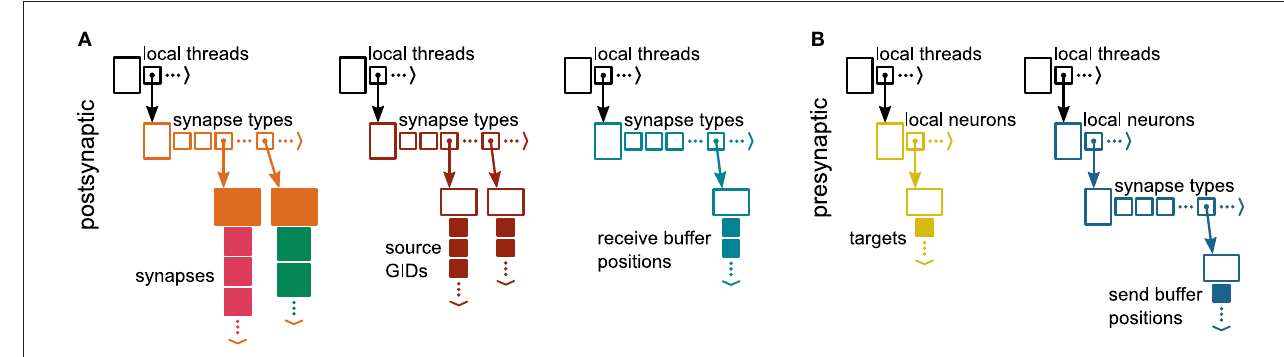
FIGURE 4 | Two-tier connection infrastructure for spiking and continuous-data connections on each MPI process. All components of the connection infrastructure hold data separated by thread using a resizable array of pointers to the thread-local data structures (top, black). (A) Postsynaptic side. The receiver side of the connection infrastructure consists of three identically structured parts: the connection table (left), the source table (middle), and the table of receive-buffer positions for continuous-data connections (right). Connection table: Thread-specific resizable arrays store pointers to variable-sized containers for every synapse type. If a synapse type is in use, the corresponding container (orange filled rectangle) stores all thread-local connections of this type in a resizable array; both spiking connections (pink filled squares) and continuous-data connections (green filled squares) are stored. Synapse types can differ in memory consumption per object, indicated by different sizes of the synapse objects. Source table: Source objects (dark red filled squares) are stored in a three-dimensional resizable array, with a one-to-one relation between each source object and the connection object in the same location in the connection table. Sources contain the GIDs of the presynaptic neurons. Table of receive-buffer positions: Thread-specific two-dimensional resizable arrays store receive-buffer positions (turquoise filled squares) for all continuous-data connections, with a one-to-one relation between each buffer position and the continuous-data connection object in the same location in the connection table. (B) Presynaptic side. The sender side of the connection infrastructure consists of the target table (left) and the table of send-buffer positions for continuous-data connections (right). Target table: Thread-specific two-dimensional resizable arrays store the target objects (yellow filled squares) for every thread-local neuron. The target objects contain the locations of the targets in terms of the MPI ranks and the locations in the corresponding connection table on the postsynaptic side. Table of send-buffer positions: Thread-specific three-dimensional arrays store the send-buffer positions (blue filled squares) for the outgoing continuous-data connections of every thread-local neuron. Adapted from Jordan et al. (2018) under CC BY 4.0 (http://creativecommons.org/licenses/by/4.0/).